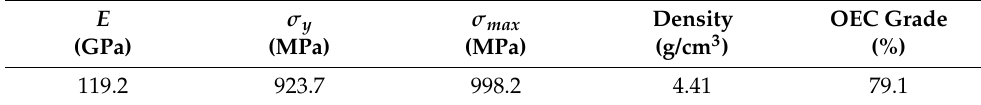
Table 9. Properties obtained using Arcam’s recommended